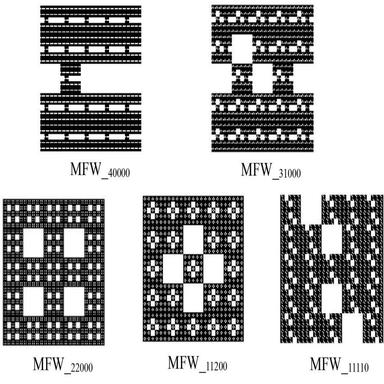
The fractal structure of MFW_40000、MFW_31000、MFW_22000、MFW_11200、MFW_11110.